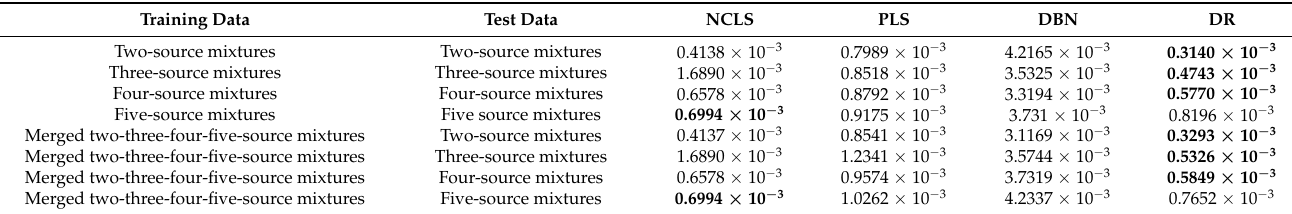
Table 4. Average RMSE results for “low-mixing-rate mixture” dataset (Mixing-rate range used for synthesizing mixtures is: [10 − 3 10 − 1 ], Min: 10 − 3 Max: 10 − 1 ). Bold numbers indicate best performing